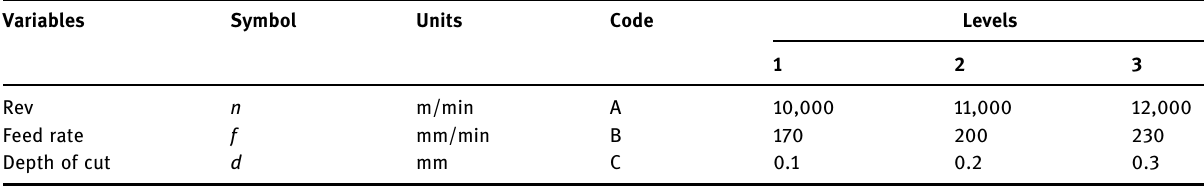
Table 2: Variables and levels Variables Symbol